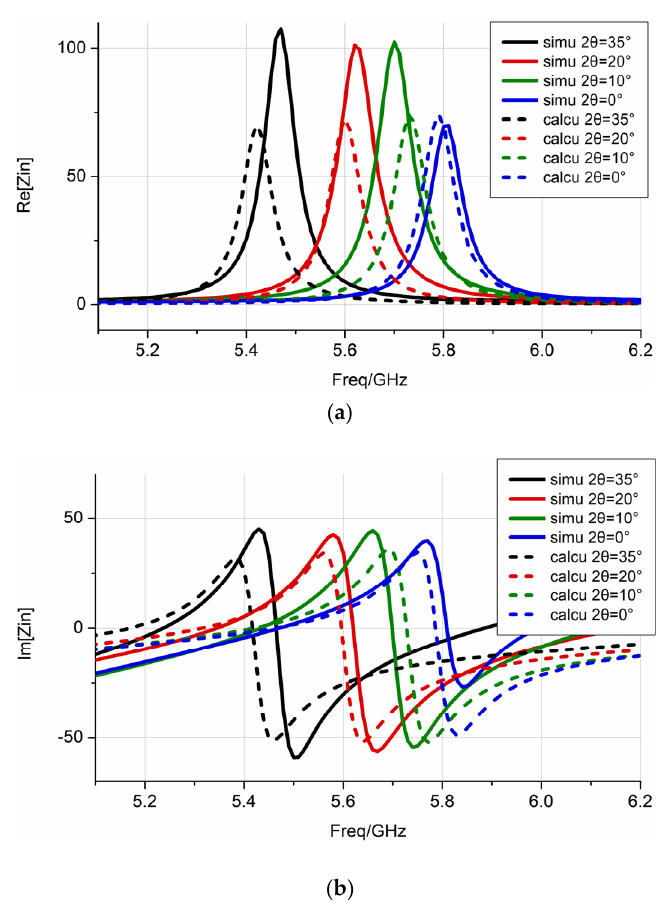
Figure 7. The impedance characteristics under different bending angles by full-wave simulation and equivalent circuit constructed are represented by solid and dashed lines, respectively: (a) real part; (b) imaginary part.